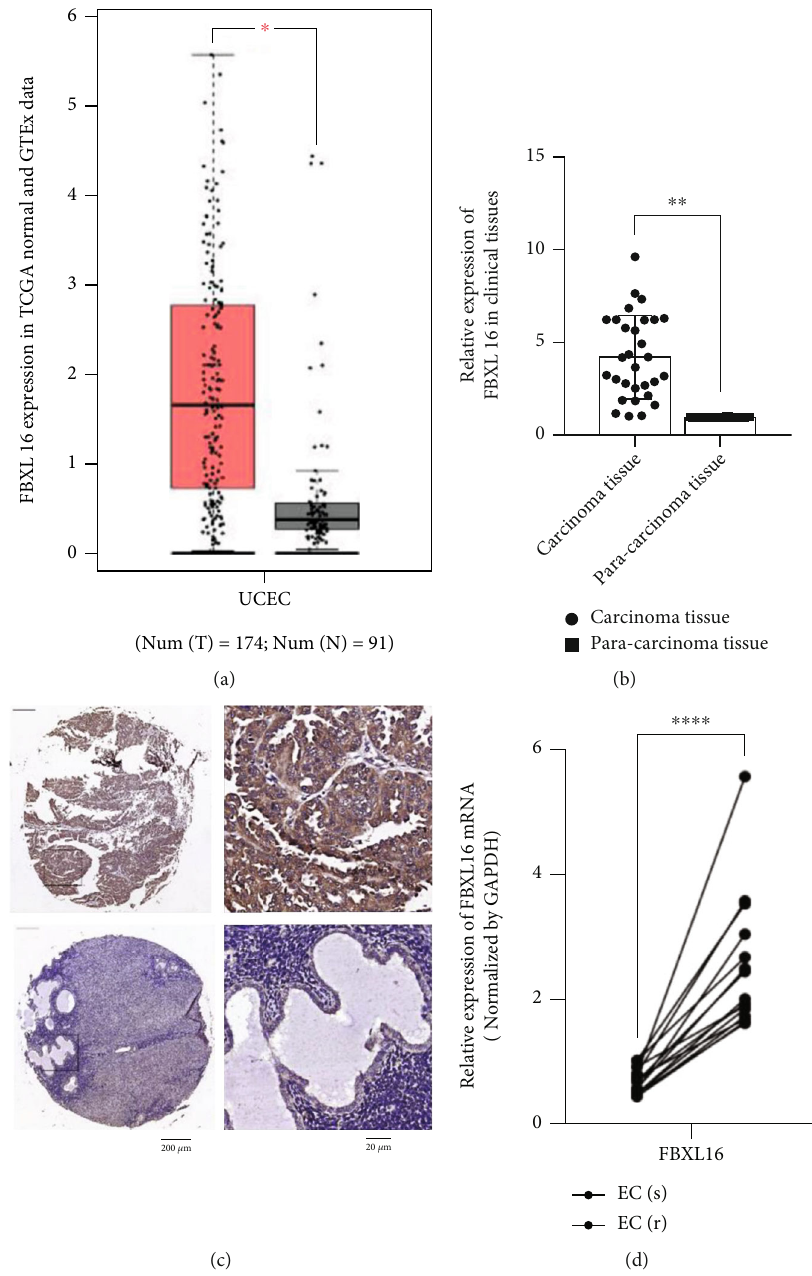
Figure 1: FBXL16 is highly expressed in MPA-resistant endometrial cancer tumors. (a) Box plot from GEPIA2 database indicated the expression of FBXL16 in UCEC tissues. (b) RT-qPCR examined the expression of FBXL16 in endometrial cancer tissues and paracancer tissues ( group = 2 , n = 30 ). (c) Immunohistochemistry analysis of FBXL16 expression in endometrial cancer tissues and paracancer tissues. (d) RT-qPCR assessed the expression of FBXL16 in EC/r and EC/s ( group = 2 , n = 15 ). Results are presented as mean ± SD . ∗ P < 0 : 05 . ∗∗ P < 0 : 01 . ∗∗∗ P < 0 : 001